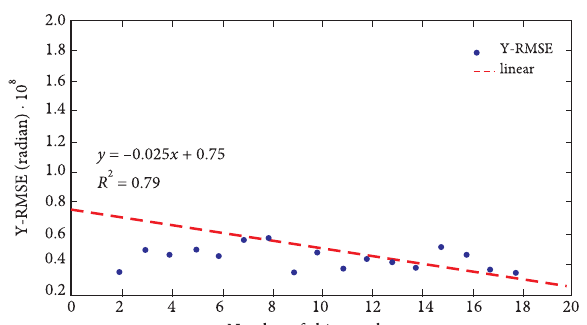
by increasing altimetry layers